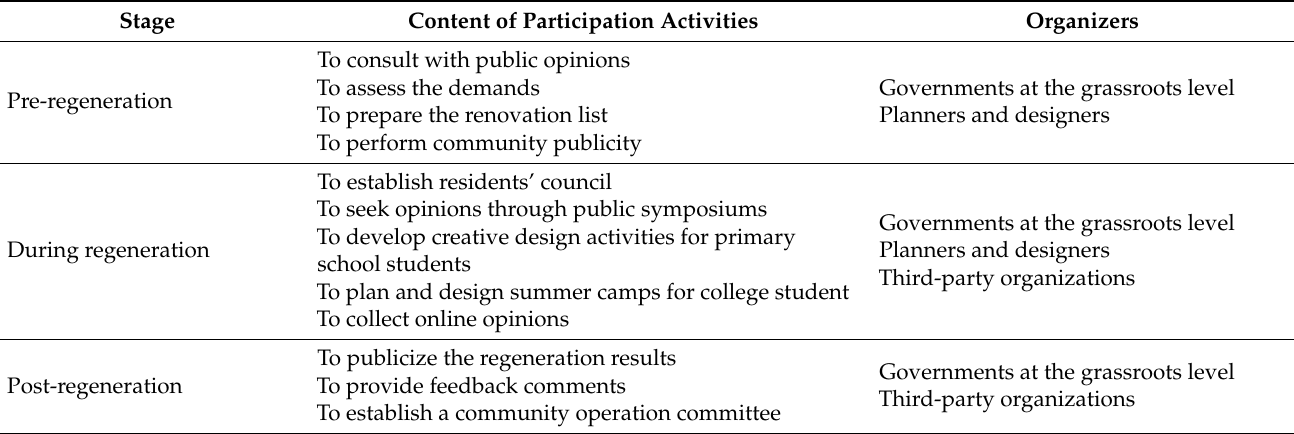
Table 2. Stages and content of public participation in community